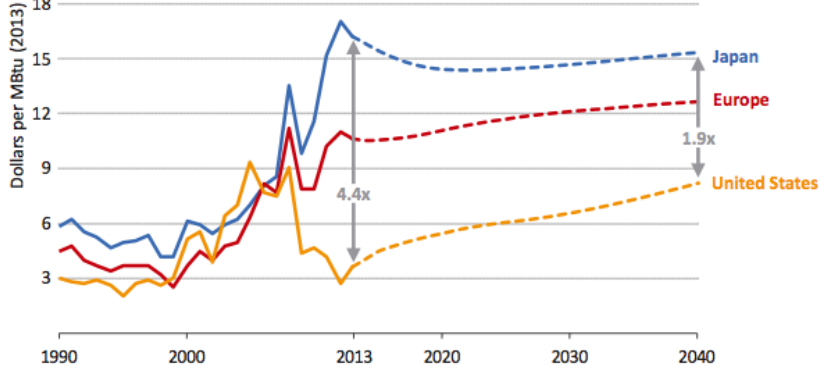
Figure 4. Natural gas price by region in the New Policies Scenario, World Energy Outlook 2014, IEA/OECD. Source: International Energy Agency (2014) [23]; Based on IEA data from IEA WEO 2014 © OECD/IEA, IEA Publishing; modified by GWG Energy and Alexa Capital. Licence: